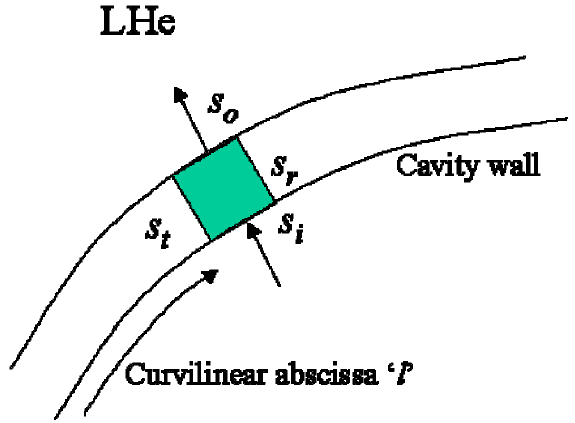
FIG. 3. (Color) Sketch of the volume element used for the temperature